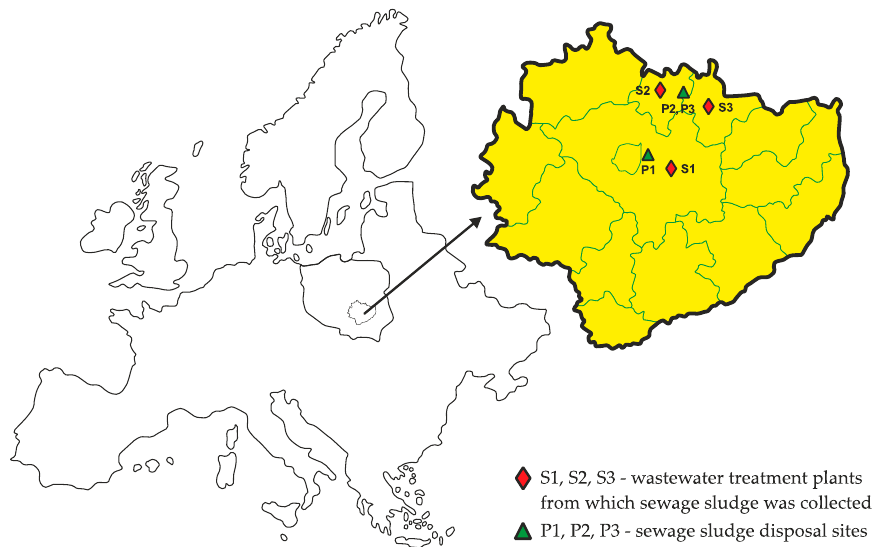
Figure 1. Location of potential disposal sites of sewage sludge and wastewater treatment plants. Table 5. Characteristics of analysed potential disposal sites of sewage sludge Table 3. Characteristics of wastewater treatment plants [27].